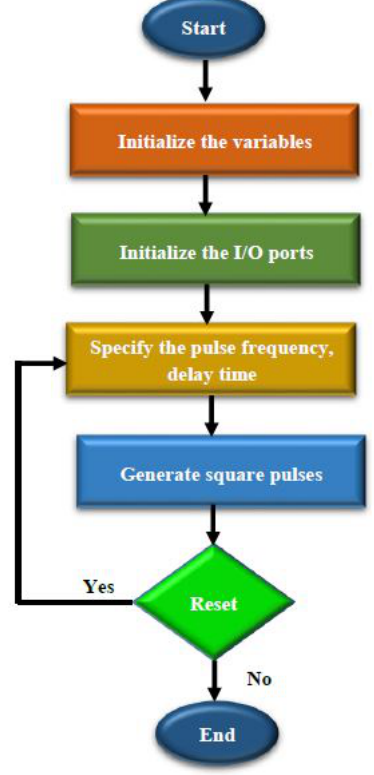
Figure 10. Flow chart of square pulse